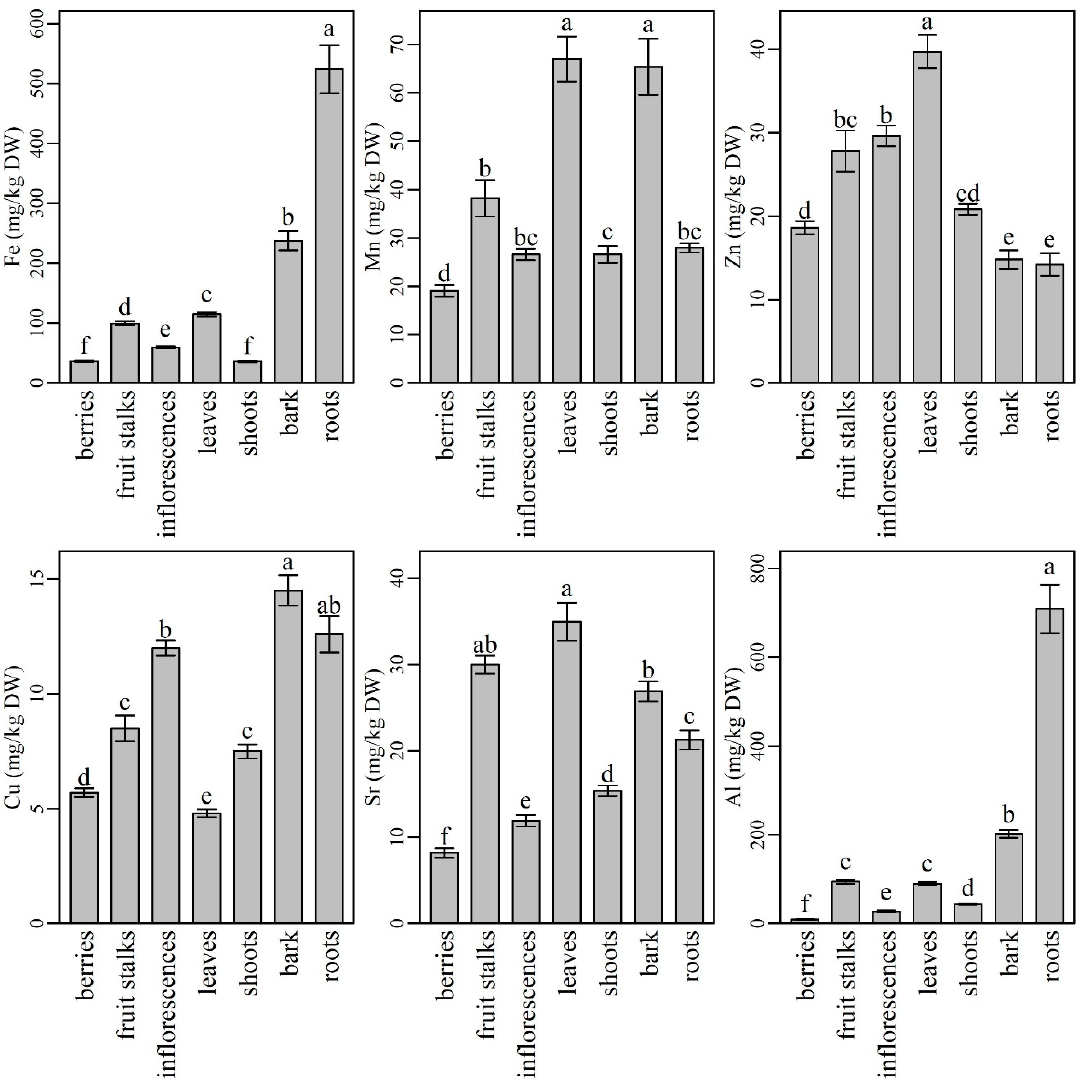
Figure 2. The content of microelements, Sr, and Al in different parts of elderberry plants. Means labelled with the same letter are not significantly different (Tukey, p ≤ 0.05).